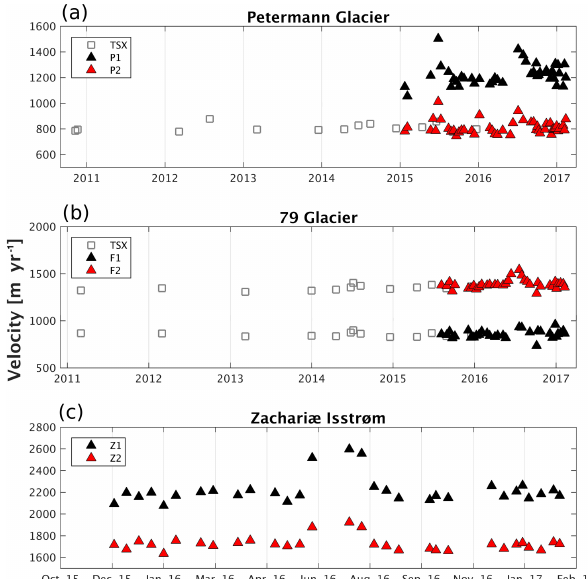
Figure 7. Temporal evolution of ice velocity at the locations indi- cated in Fig. 1 over (a) Petermann Glacier, (b) Nioghalvfjerdsfjor- den and (c) Zachariæ Isstrøm. The data derived from TerraSAR-X (11 days – Joughin et al., 2016) and Sentinel 1-a/b (6 to 12 days) are represented as grey squares and coloured triangles,